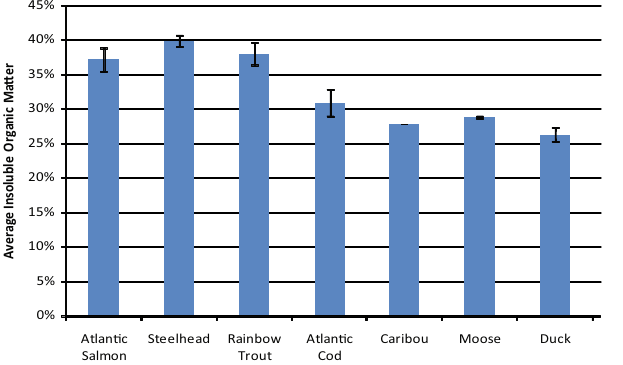
Figure 1. Content of Acid Insoluble Organic Matter Extracted from Unheated Air-Dried Salmonid, Codfish, Caribou, Moose, and Duck Bones. Results illustrate greater organic matter contents in salmonid